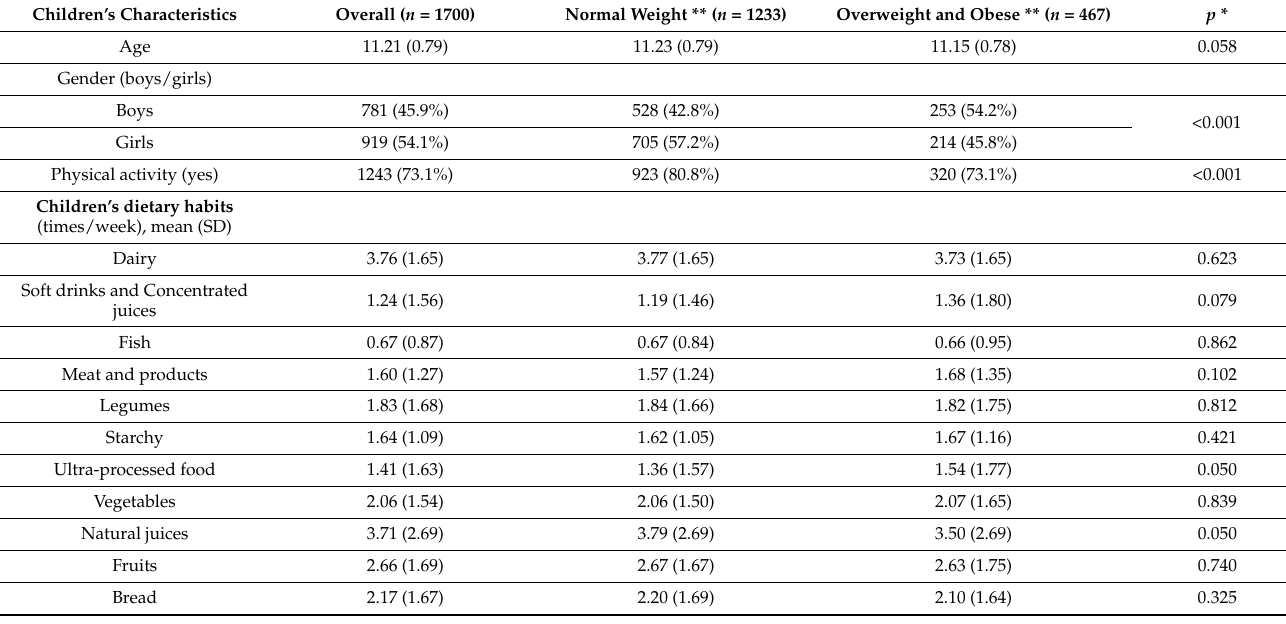
Table 1. Children’s socio-demographic characteristics and eating habits, by body weight